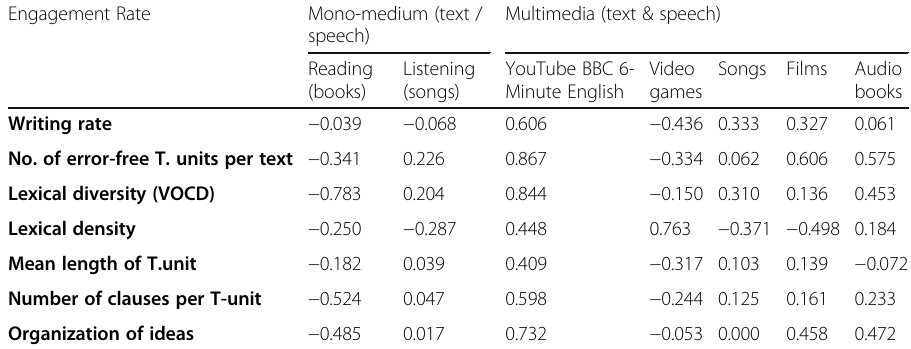
Table 2 Pearson ’ s correlation coefficient: Engagement Rate (Online learning) Engagement